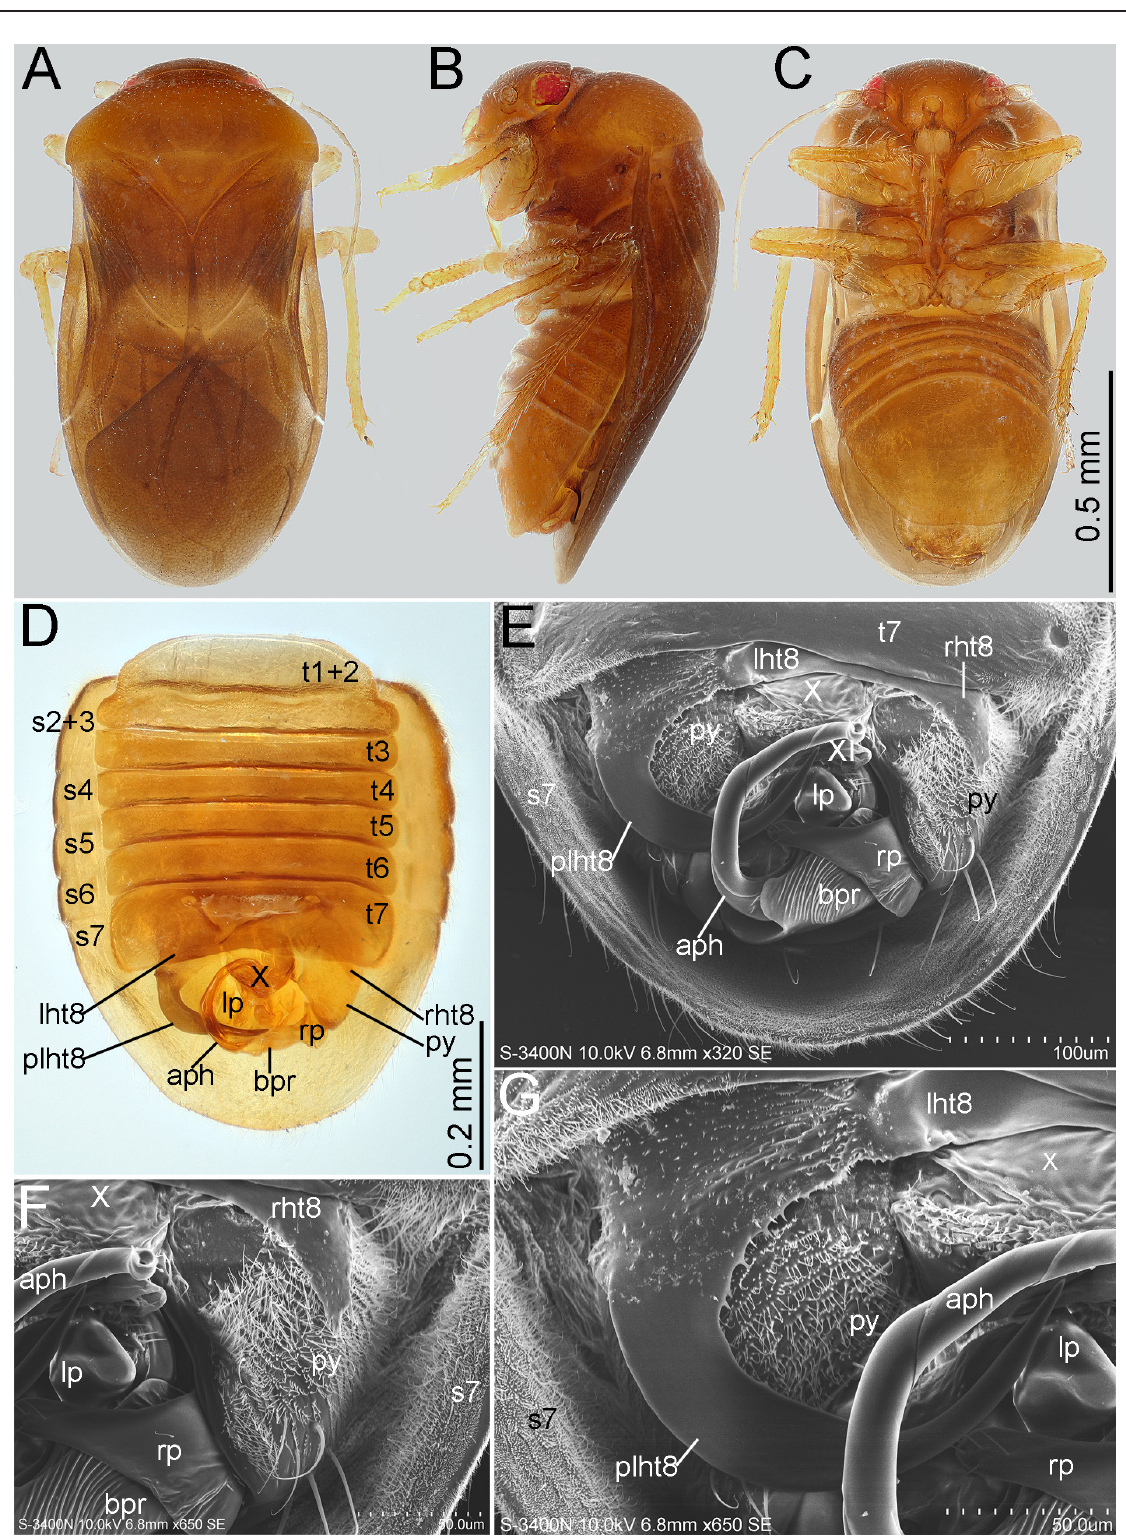
Fig. 9. Kokeshia drepanoides sp. nov. A‒C . Habitus, holotype, ♂ (NKUM). A . Dorsal view. B . Lateral view. C . Ventral view. D . Pregenital abdomen and genitalia, dorsal view, paratype, ♂ (SYSBM). E‒G . Scanning electron micrographs of genitalia, paratype, ♂ (SYSBM). E . Dorsal view. F . Right side, dorsal view. G . Left side, dorsal view. Abbreviations: see Material and